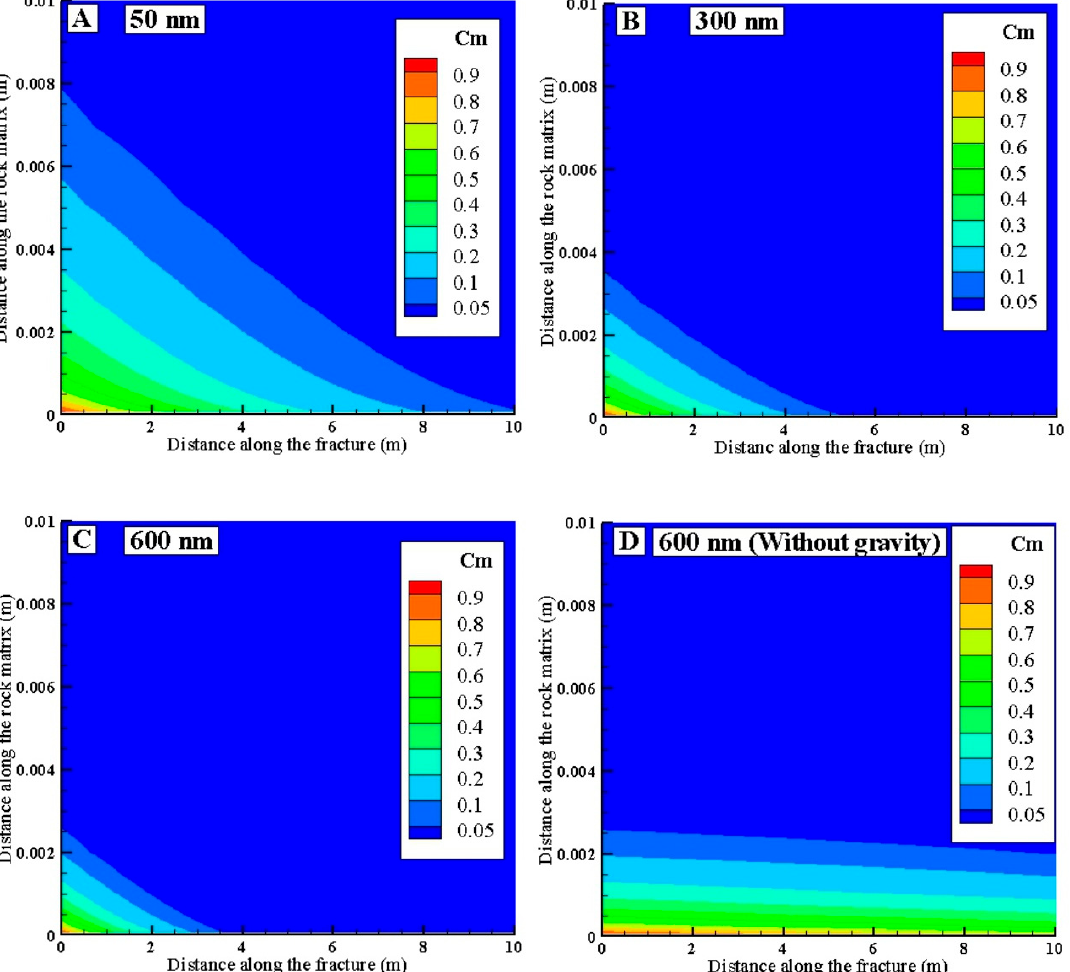
Figure 7. Contour plots depicting the diffusion of colloids within the rock matrix for three different values of colloid size 50 (7A), 300 (7B), and 600 nm (7C) at 3000 kg/m 3 colloid density and when there is no gravitational force (7D).